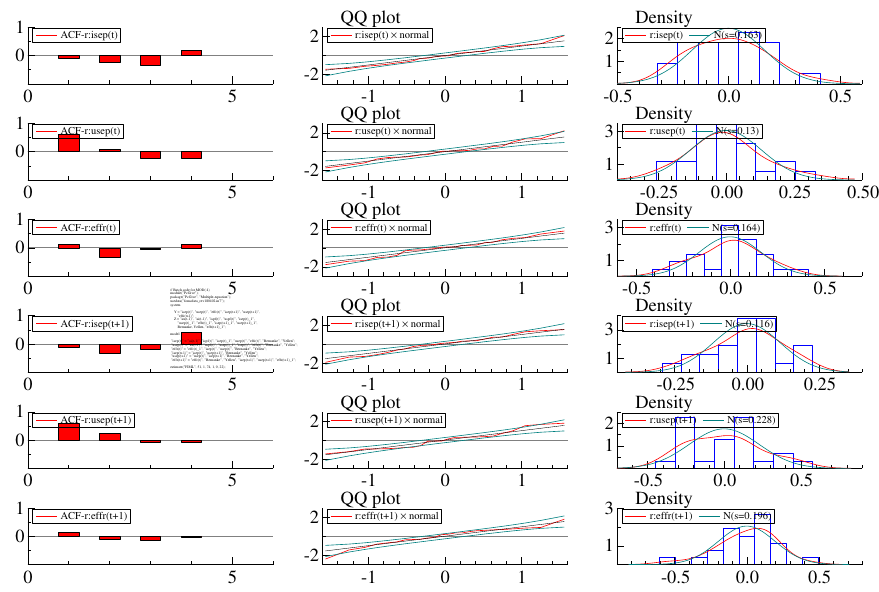
Figure 12. Tests of Serial Independence and Normality of Disturbances for FIML.